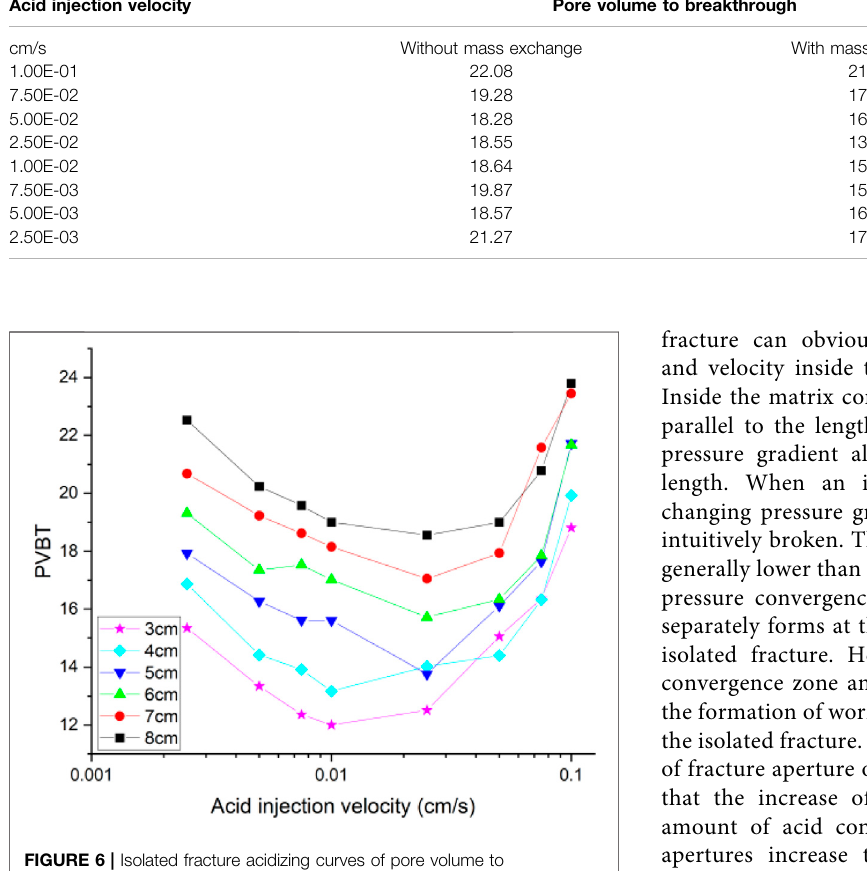
FIGURE 6 | Isolated fracture acidizing curves of pore volume to breakthrough with different lengths.